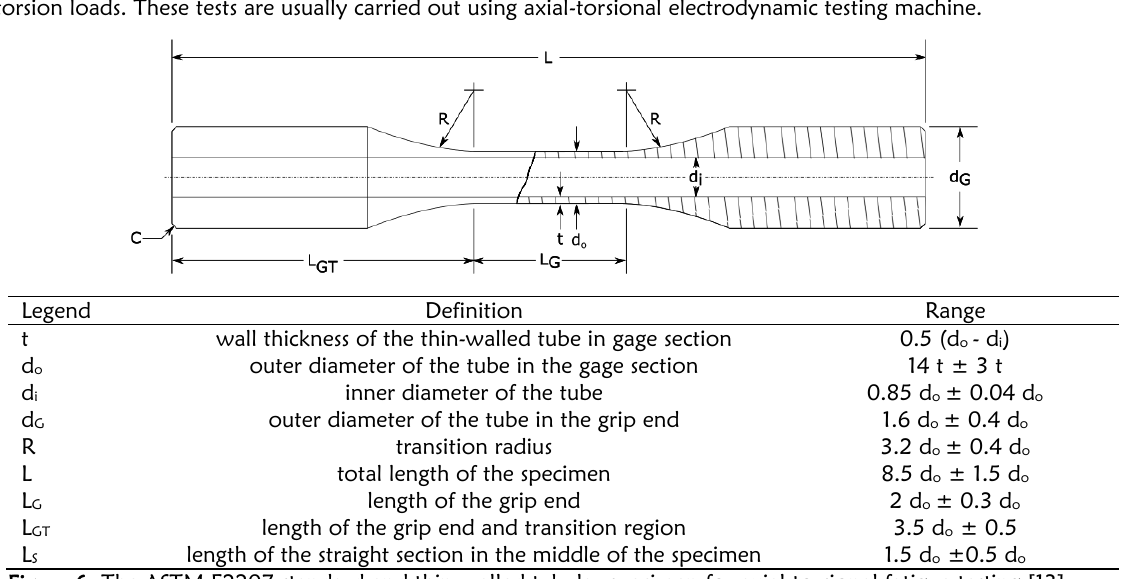
Figure 6: The ASTM E2207 standard and thin-walled tubular specimen for axial-torsional fatigue testing